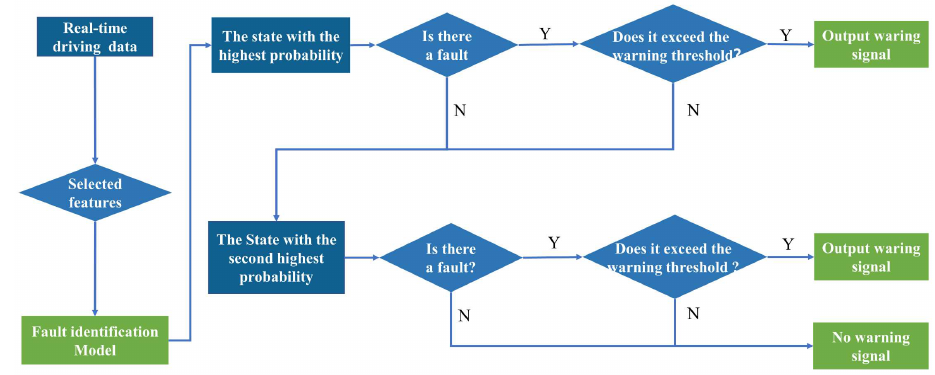
Figure 3. Structure of dual probability early warning threshold model.